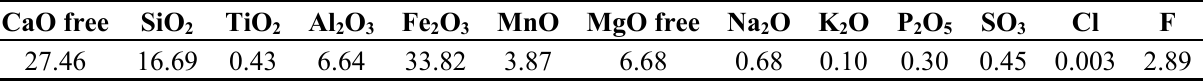
Table 1. Chemical composition of steel slag samples, mass percent (%). CaO